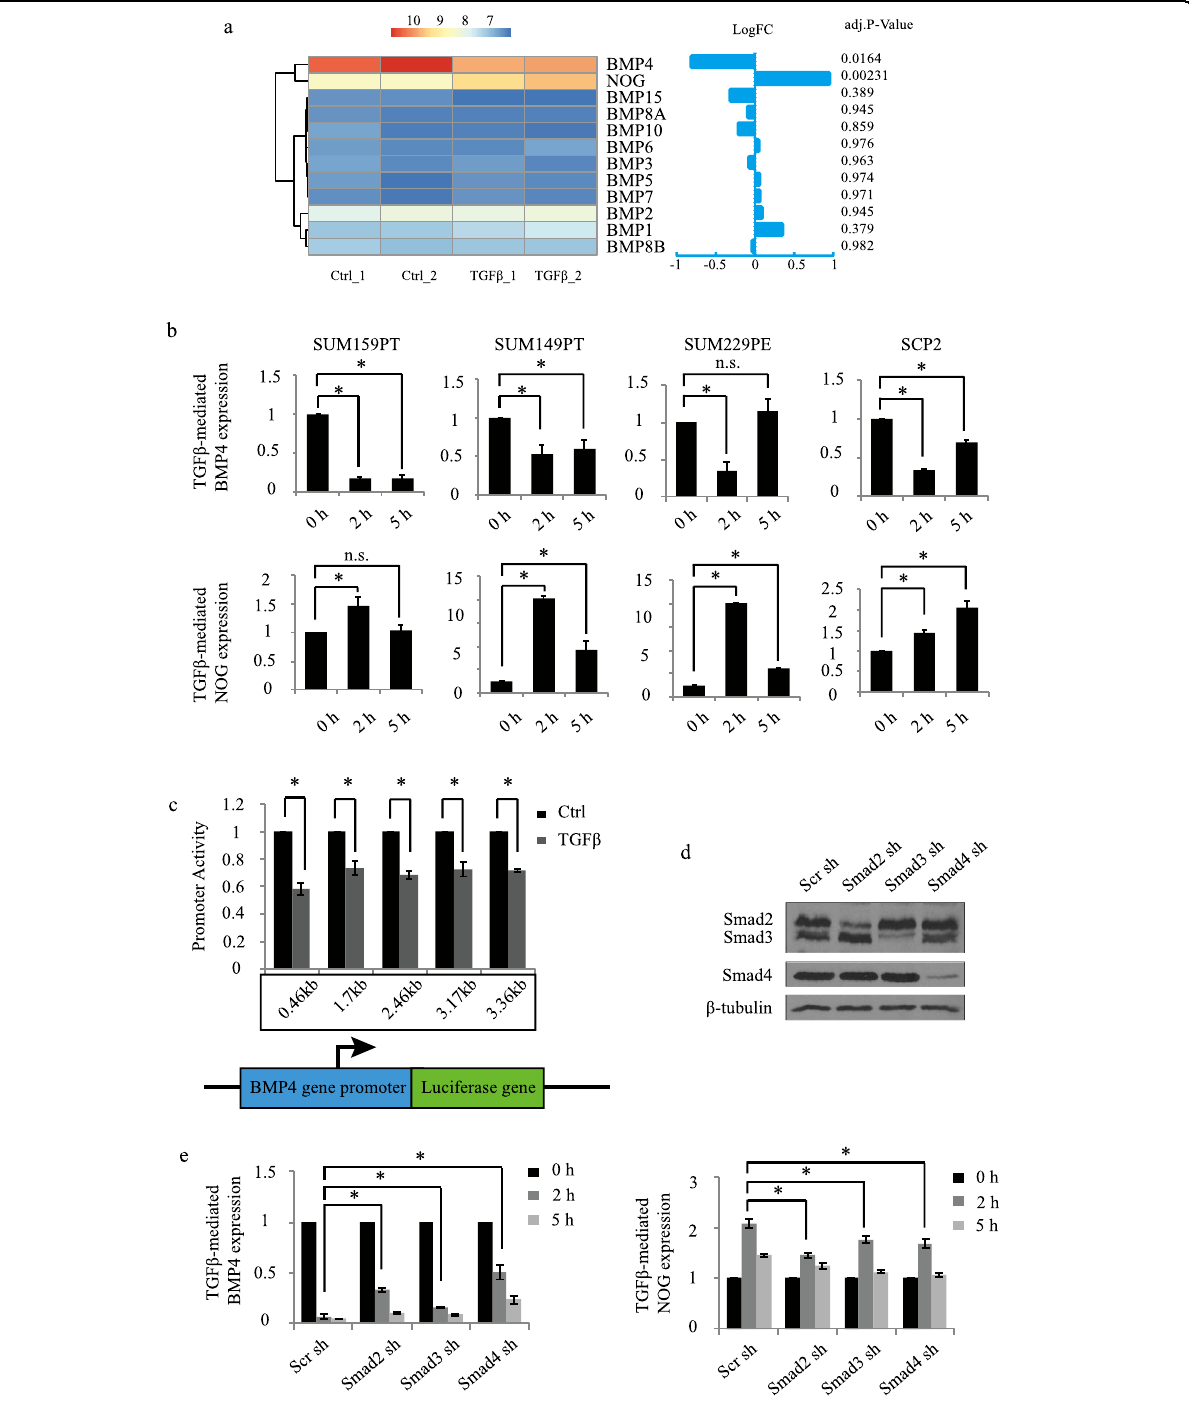
Fig. 2 BMP4 and NOG are inversely regulated by TGF β . a Heatmap representing the TGF β effects on BMP family members and NOG expression with log fold change and adjusted P value. b QPCR analysis of BMP4 and NOG in various TNBC cell lines. Data represent means ± SEM of triplicate experiments. * P ≤ 0.05; n.s. not signi fi cant. c TGF β effects on progressive deletion constructs of the BMP4 gene promoter fused to luciferase. Data were normalized to the control group, and graphs are means ± SEM from triplicate data. * P ≤ 0.05; n.s. not signi fi cant. d Immunoblots of the Smad knockdown ef fi ciencies. e Smad knockdown effects on TGF β -mediated BMP4 and NOG